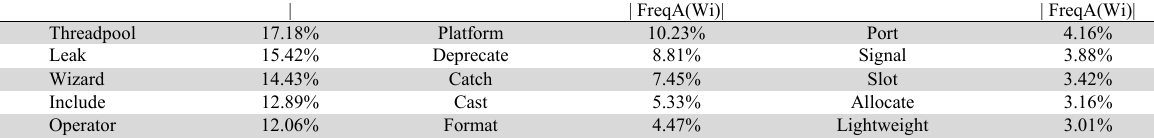
Fig. 2. The distribution of fi x rate for bugs over the components of KOffice. The x-axis shows the speci fi c component, while the y-axis shows the computed AdpFixCont and NAdpFixCont Top 15 Words With Probability Close To 1 Ordered By Occurrence Frequency In Corpus_A For The Koffice